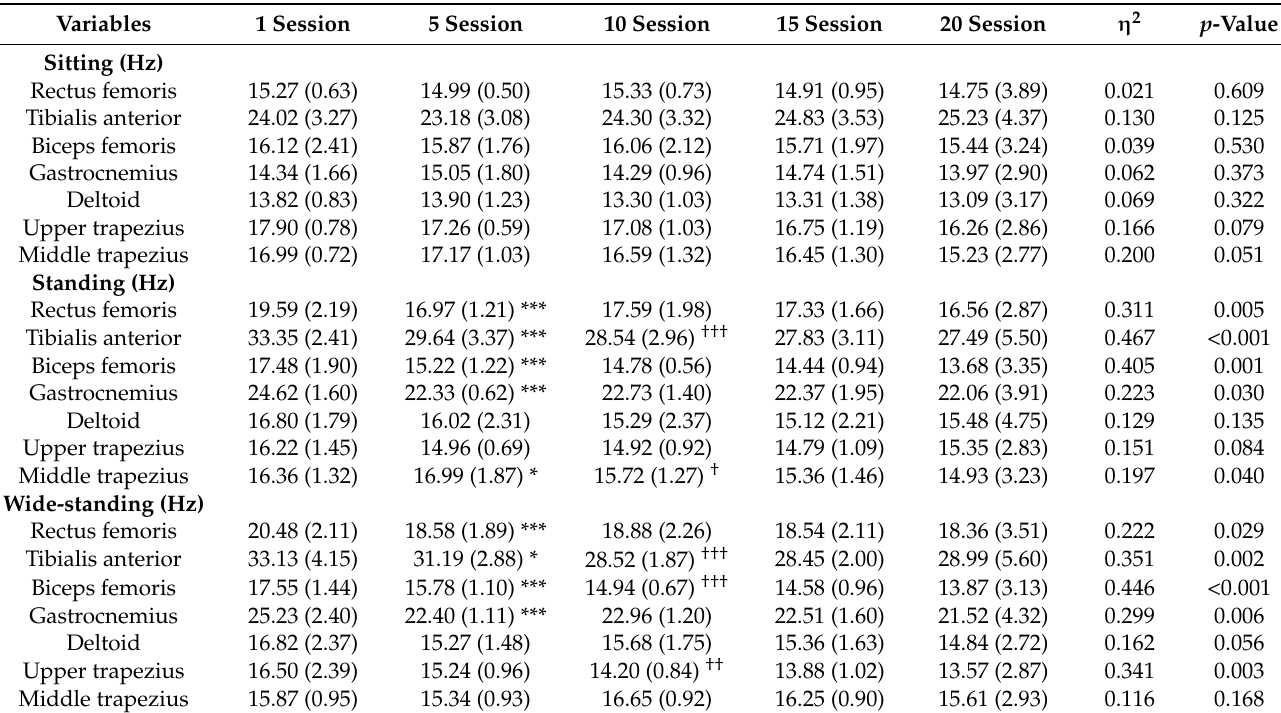
Table A3. Muscle tone during the locomotion training protocol.